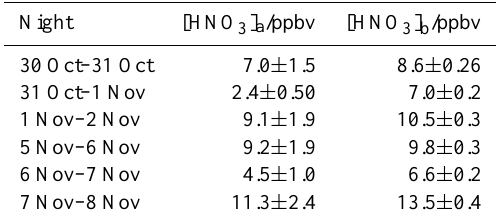
Table 2. Total calculated night-time [HNO 3 ], using [N 2 O 5 ] and τ ss (N 2 O 5 ) , (2nd column); and using k 2 , [NO 2 ] and [O 3 ], (3rd col- umn) of Eq. (9) for nights where a continuous dataset for all param- eters were used.